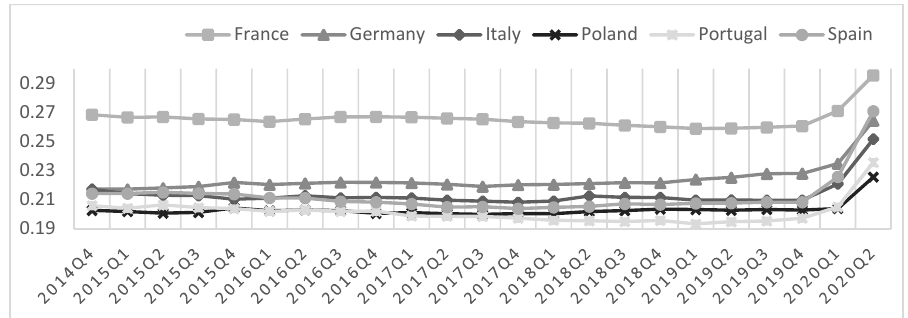
Figure 2. The coefficient of government spending in the gross value added, own work, source: Eurostat.